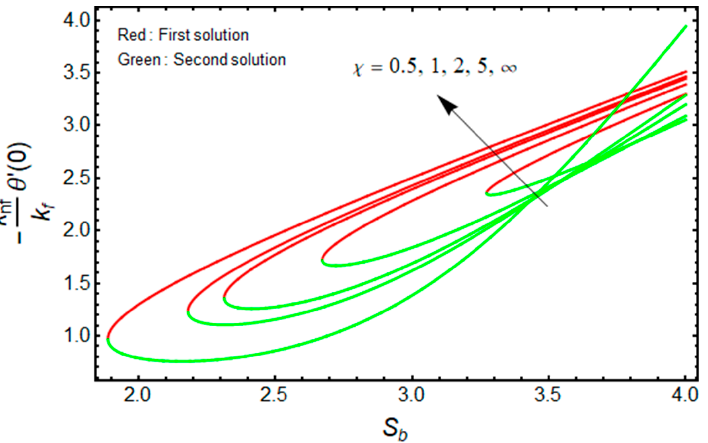
(cid:16) (cid:17) χ χ χ on on k nf / k f θ (cid:48) ( 0 ) versus S b when φ = 0.025, M b = 0.5, R d = 1.5, m = 1. on